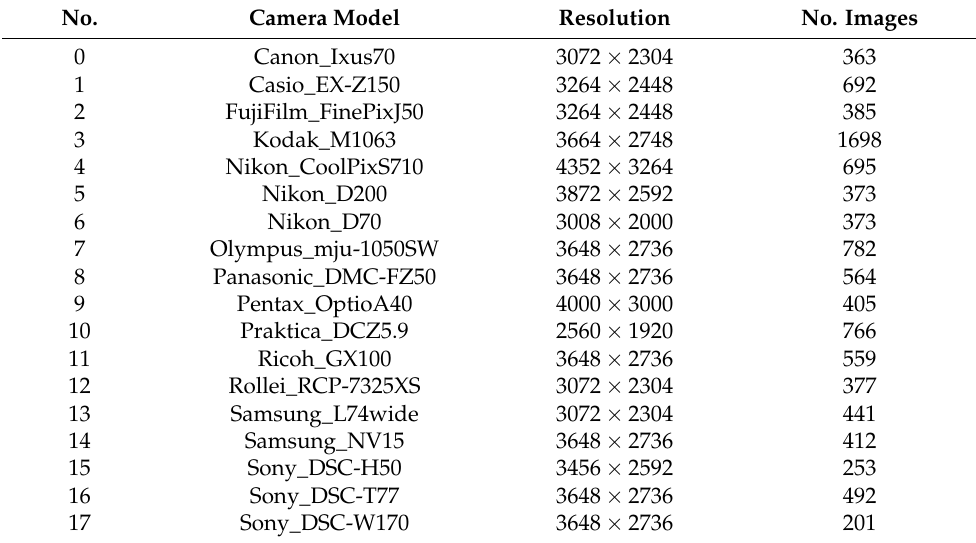
Table 1. Details of camera models used in experiments.